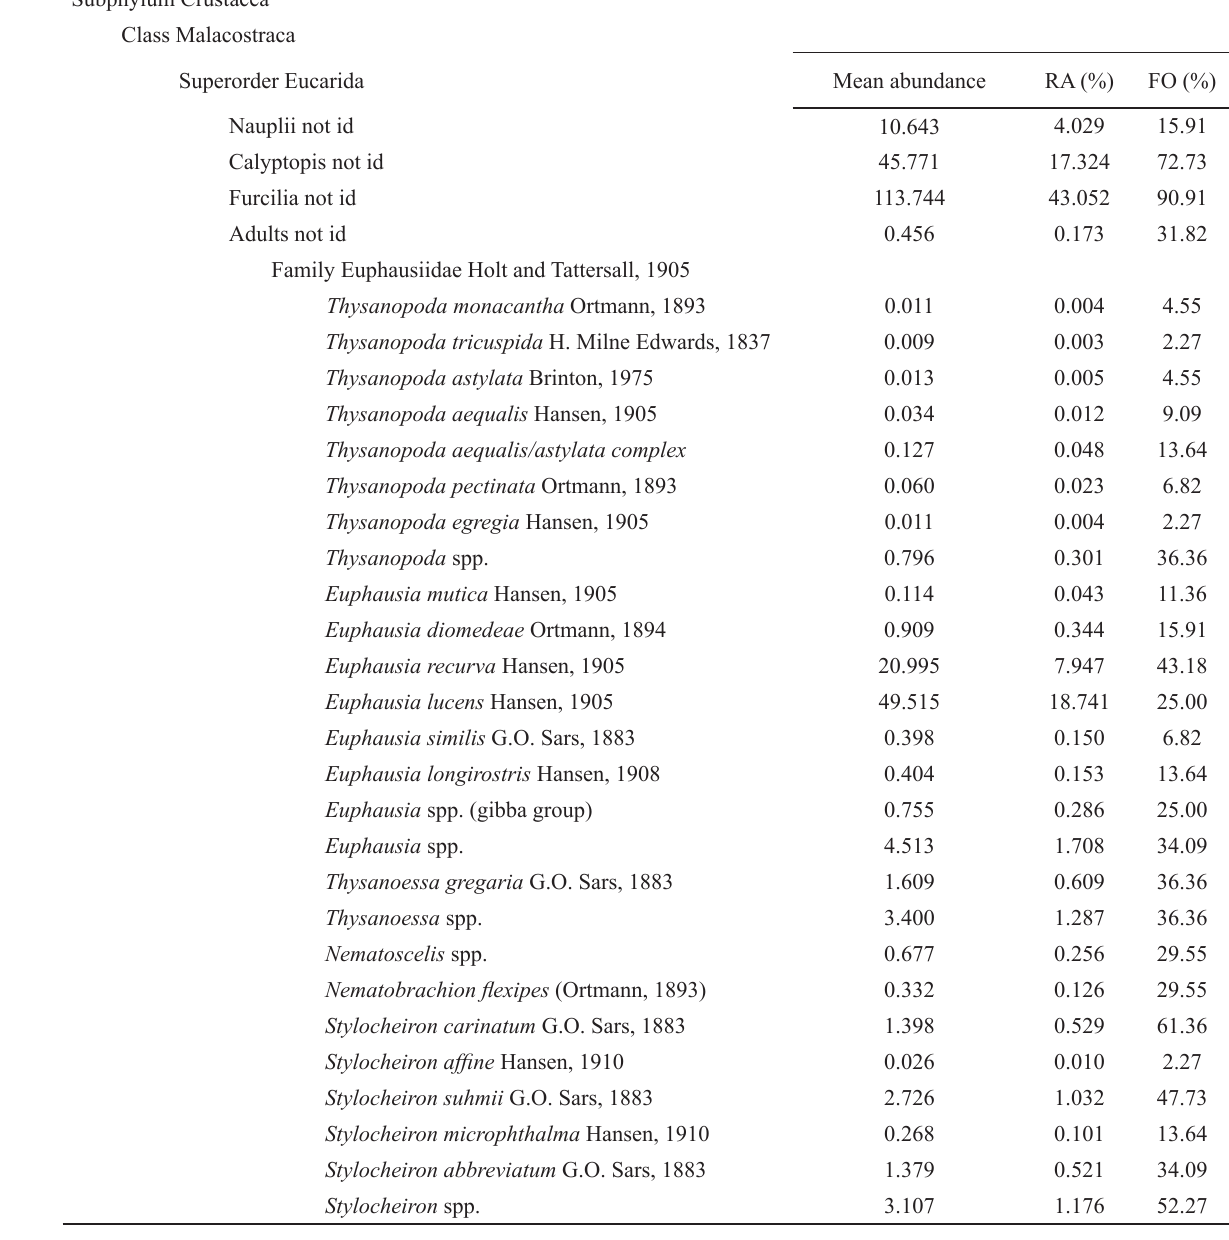
List of euphausiid taxa recorded along the 30° S transect through the South Atlantic Ocean during the First Transatlantic Commission (Brazil/Africa) in 2009 with the mean abundance (organisms 100 m -3 ), relative abundance (RA) and frequency of occurrence